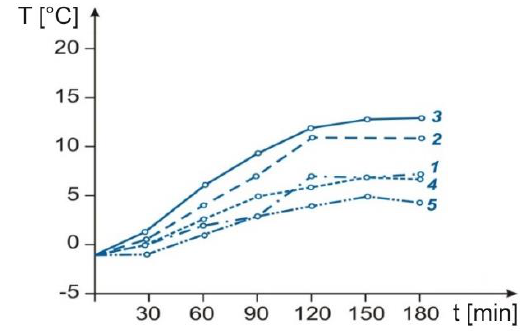
Figure 7. Temperature on the stock-rail head [14].